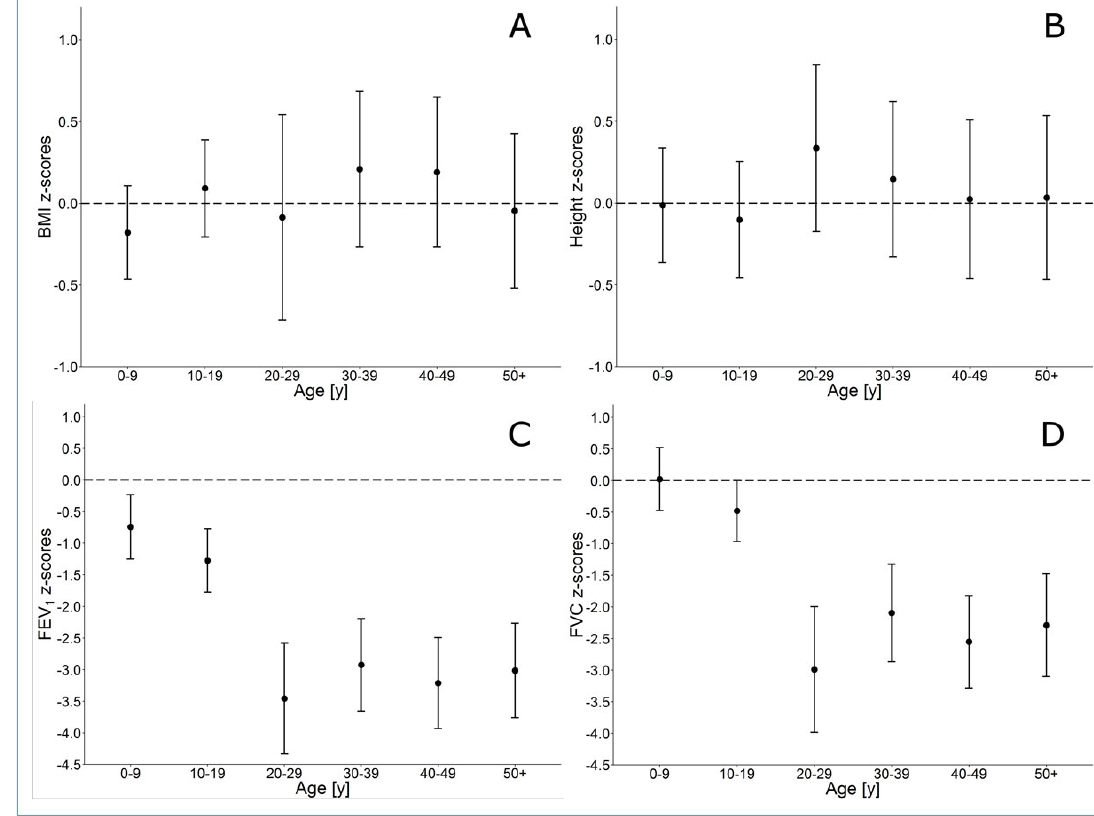
Figure 4: Growth and lung function of patients participating in the Swiss PCD registry.Height (A) and BMI (B) by age group compared to na- tional references (Braegger et al. Paediatrica. 2011;22:9–11 [32]); FEV 1 (C) and FVC (D) by age group compared with GLI international refer- ences (Quanjer et al. Eur Respir J. 2012;40:1324–43 [34]). All values are presented as mean z-scores (95% confidence intervals) after adjust- ing for sex and level of diagnostic certainty, calculated using multivariable linear regression